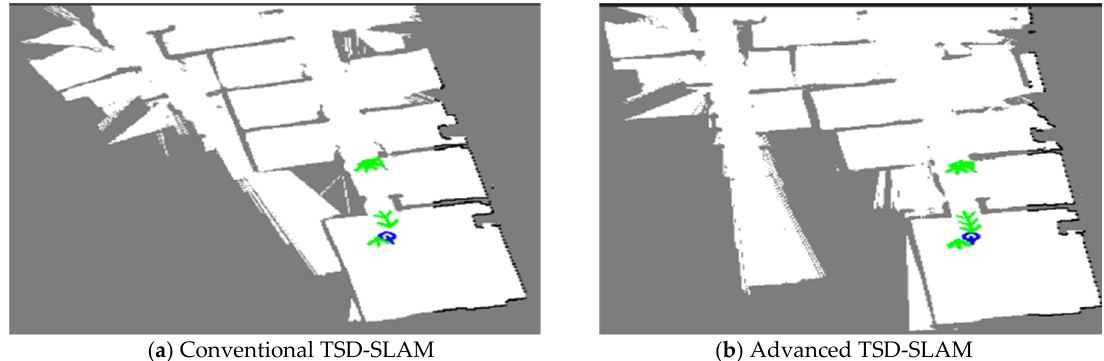
Figure 12. Comparison of the conventional TSD-SLAM and the advanced TSD-SLAM. The left part of the map was not built accurately in ( a ), but the matching errors were reduced in ( b ).